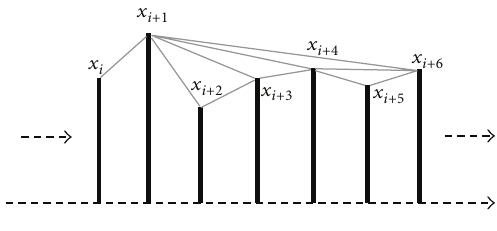
Figure 1: Visibility Graph for time series 𝑋